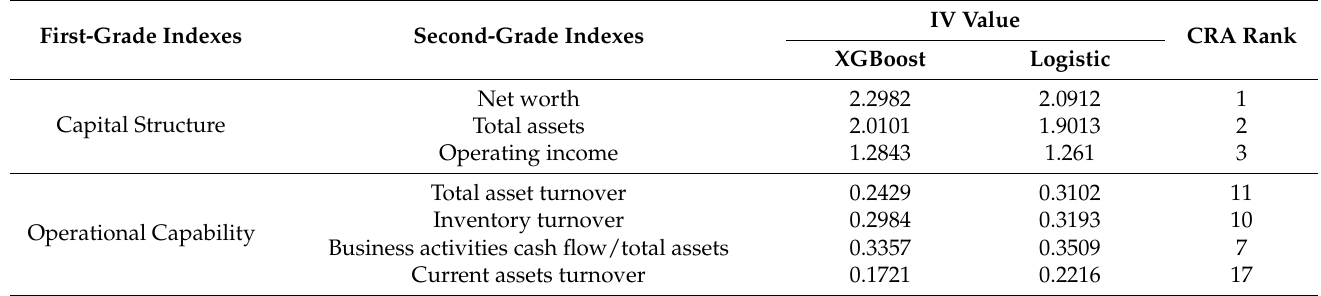
Table 5. Explanatory variant importance